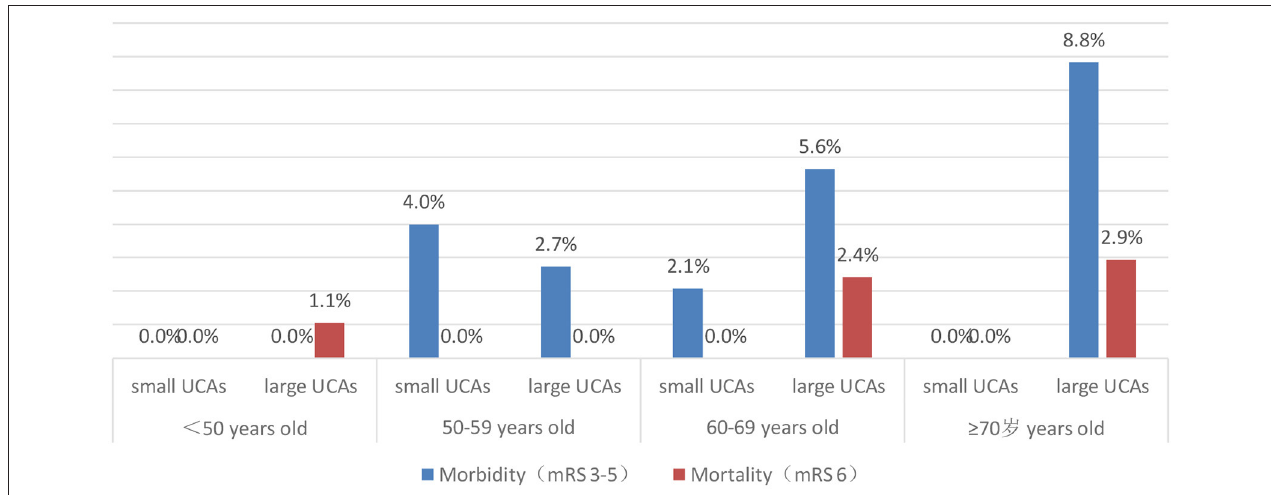
FIGURE 2 | The distribution of morbidity and mortality according to age of patients.